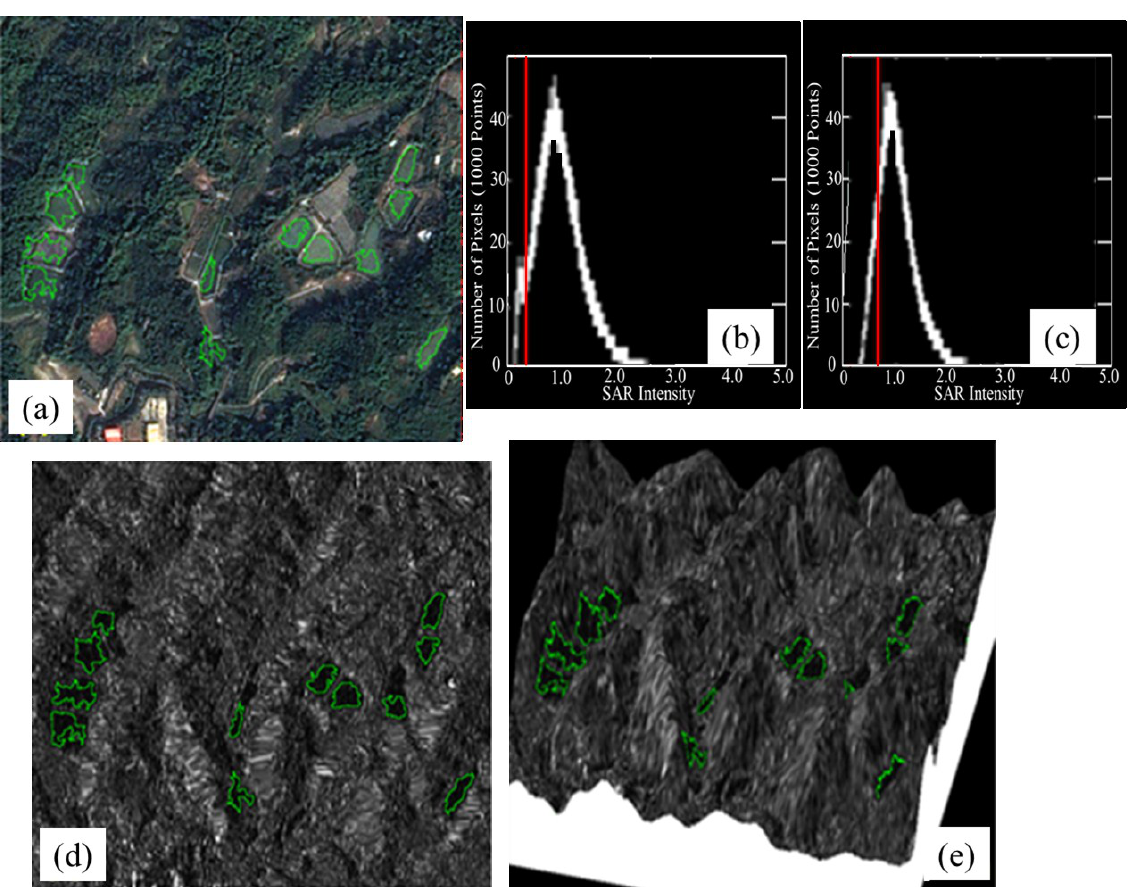
Figure 7. An example of flood extent detection using ESARIWDS. ( a ) The most recent optical image of the same area taken by Formosat-2; ( b ) like-polarization histogram; ( c ) cross-polarization histogram; ( d ) dark regions in the SAR image; ( e ) overlaying the SAR image and the boundary of dark regions onto the corresponding DEM to visually examine the topographical relationship of each dark